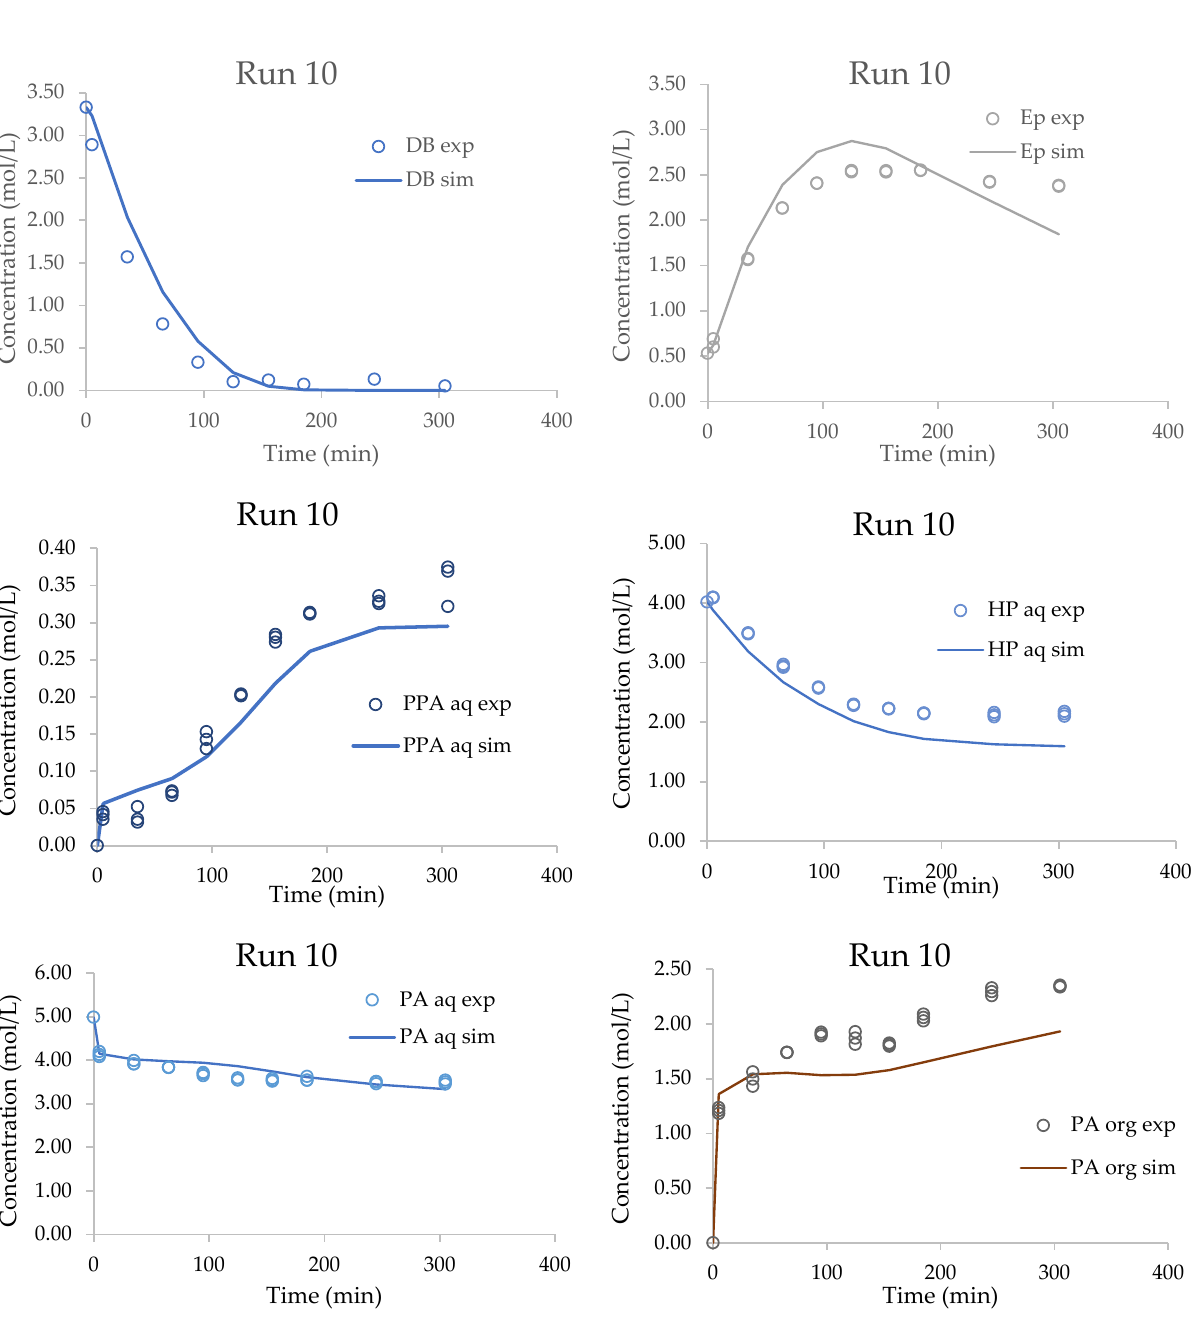
Figure 13. The fit of the model to Run 10. (DB: double bond, EP: epoxide, PPA: perpropionic acid, PA: propionic acid, and HP: hydrogen peroxide).